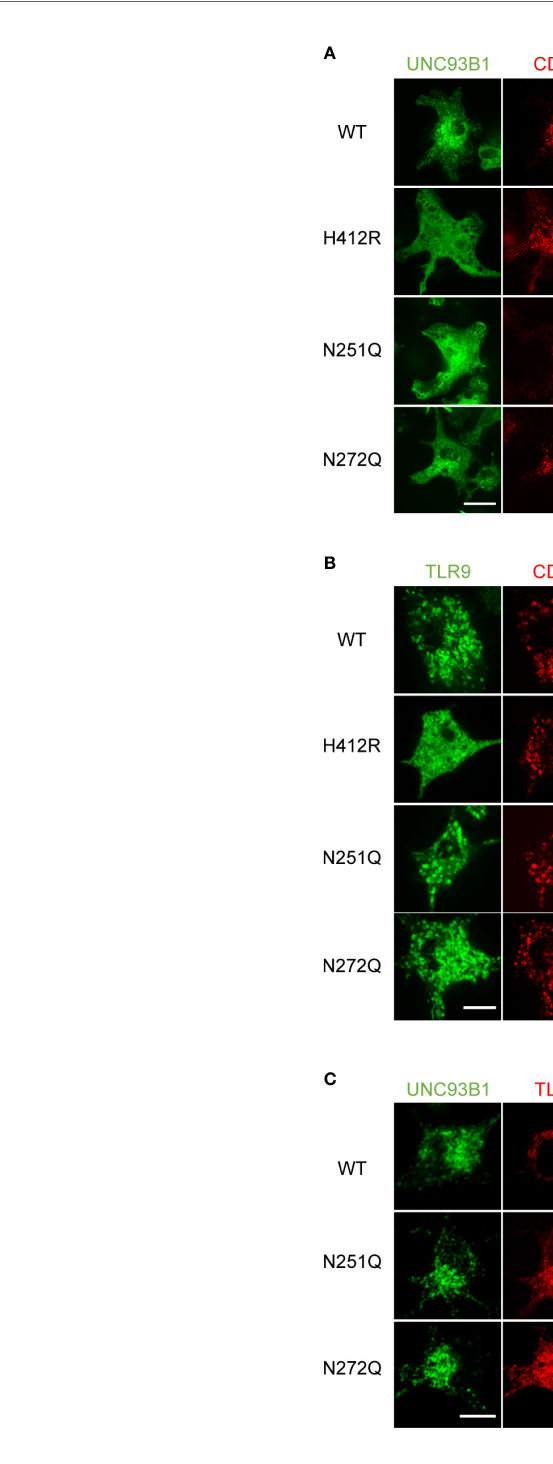
FIGURE 4 | Intracellular localization of UNC93B1 and TLR9 is unaffected by defective N-glycosylation of UNC93B1. (A) UNC93B1-GFP (wild type or mutant) and CD63- cherry were expressed in UNC93B1 KO BMDCs and cells were imaged by confocal microscopy. Scale bar, 10 m m (B) TLR9-GFP and CD63-cherry were expressed in UNC93B1 KO BMDCs together with either wild type or mutant UNC93B1-HA. Localization of TLR9-GFP and CD63-cherry were detected by confocal microscopy. Scale bar, 5 m m (C) Wild type or mutant UNC93B1-GFP were expressed in UNC93B1 KO BMDCs together with TLR9-myc. After fi xation and permeabilization, cells were stained with anti-myc antibody and Alexa Fluor 647-conjugated secondary antibody and imaged by confocal microscopy. Scale bar, 10 m